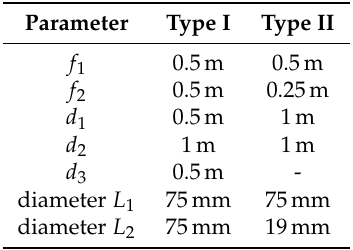
Table 1. Configuration parameters for the test systems used in the ray